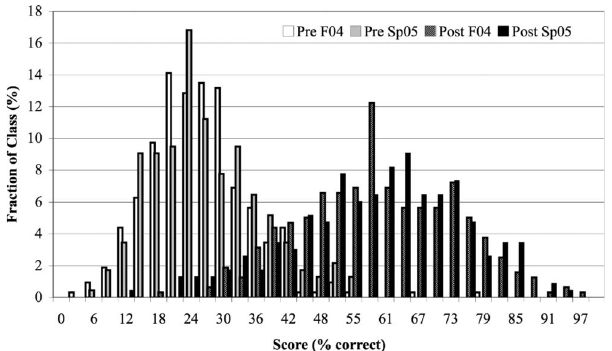
FIG. 2. BEMA results pre- (cid:1) left (cid:2) and post- (cid:1) right (cid:2) , shown as % correct. The data show two semesters of results in different shades. The term-to-term reproducibility of these histograms is striking. The two semesters were taught by different faculty, both